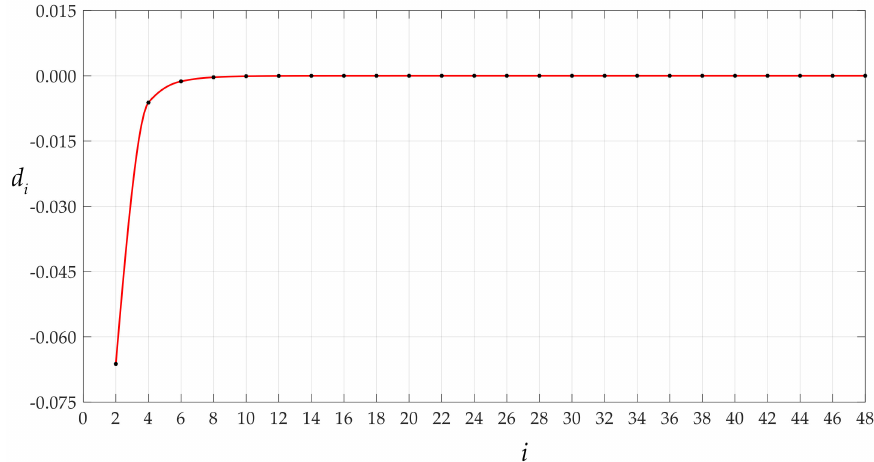
Figure 10. Variations of d i with i when q takes 0.00004 MPa.